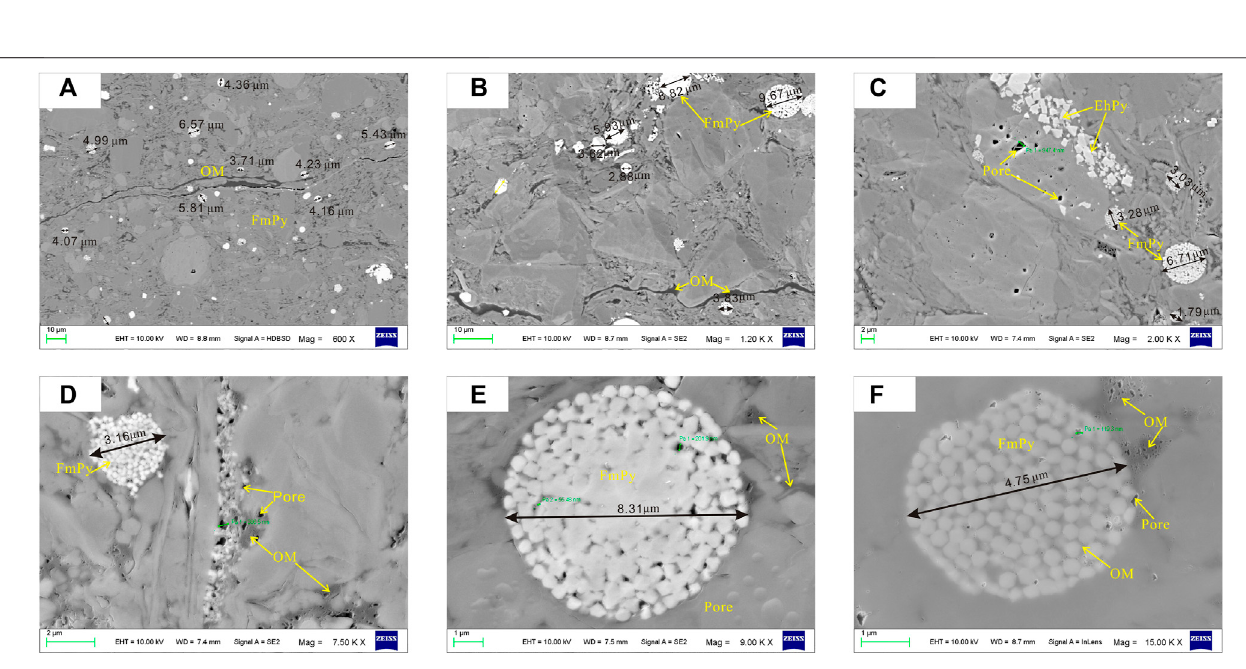
Frontiers in Earth Science |